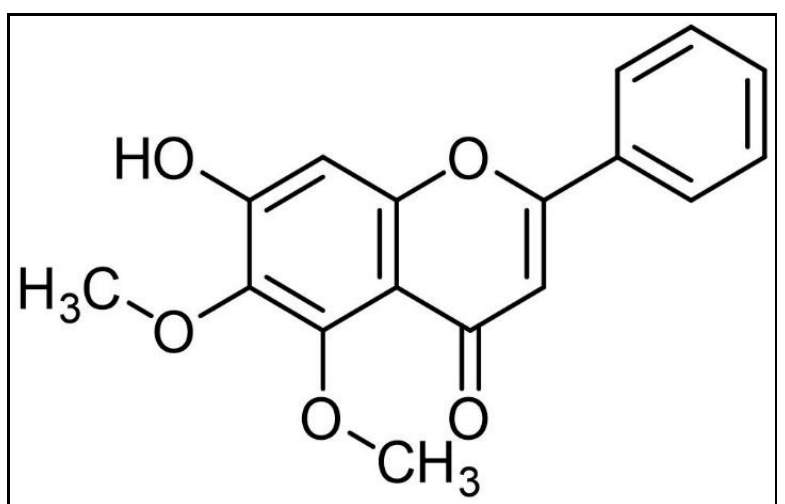
Figure 6. Chemical structure of compound 1, baicalein 5,6-dimethyl ether.